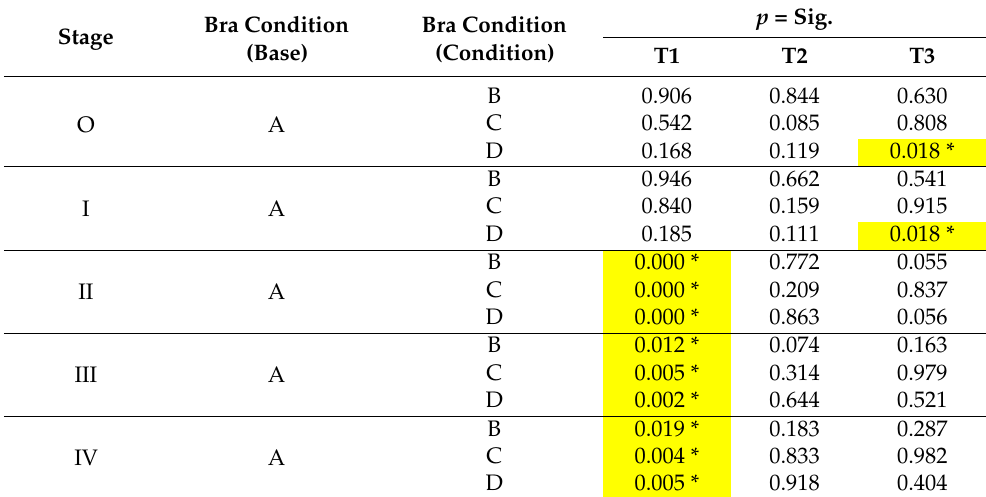
Table 4. Statistical results of skin temperature at T1, T2 and T3 in Stages 0 to